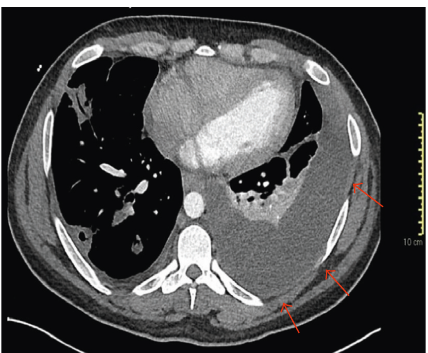
Figure 2: Arterial-phase axial computed tomographs of the lower thorax demonstrating a moderate left pleural effusion with associated compressive atelectasis. Peripheral cavitary pulmonary lesions and partially visualized tricuspid valve (with known vegetation) are